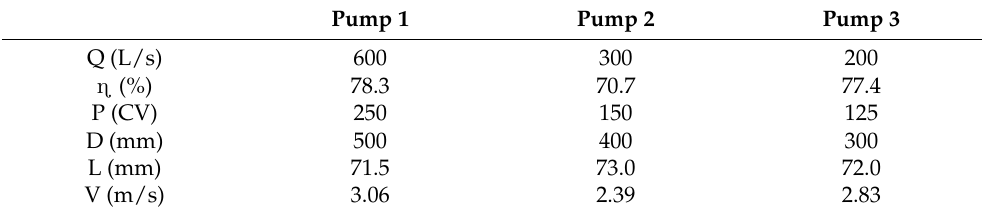
Figure 2. Elevated Pumping Station II, Rio Branco, Acre, consisting of a set of vertical turbine-type Table 1. Characteristics of the pipes coupled to the 3 representative pumps adopted to pump from the river to the desander of the river channel—Rio Branco/Acre